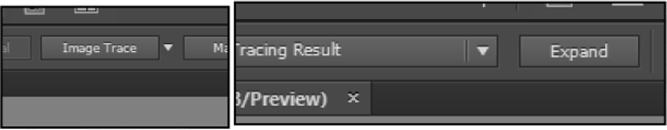
Select the overall image and head to the top option to “Image Trace”, selecting the arrow on the right and choosing “High Fidelity Photo”. Next, select the button on the right of where Image Trace was, “Expand”.